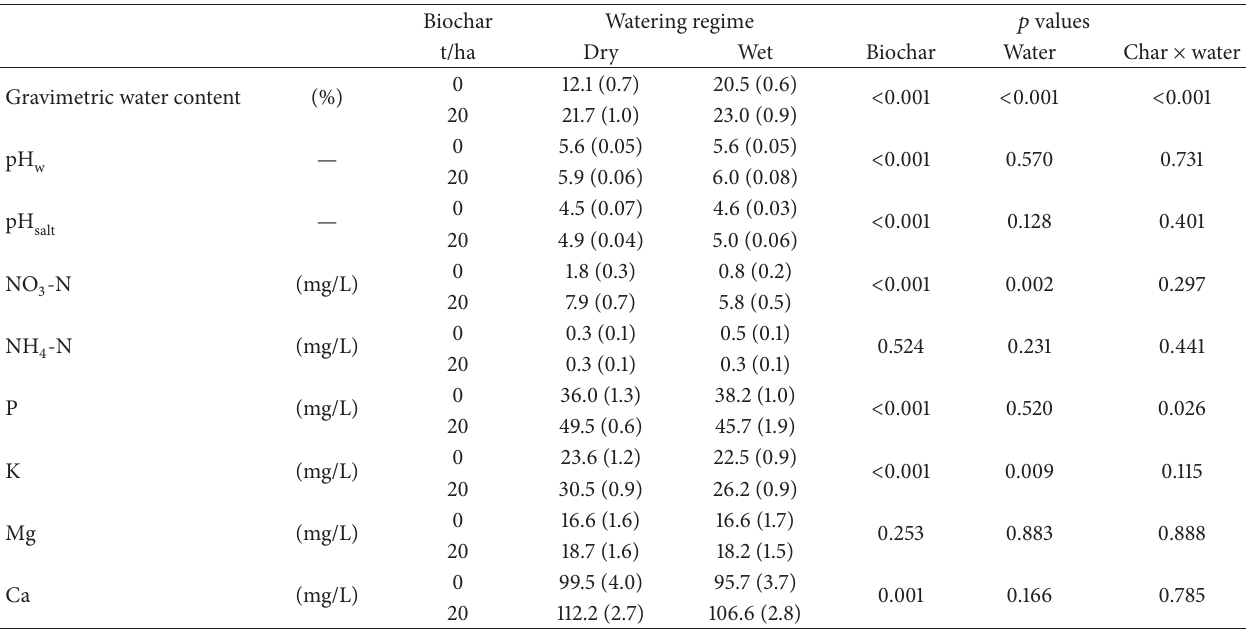
Table 2: Soil properties after a six-month greenhouse trial with lodgepole pine-derived biochar and soil from areas affected by the Church’s Park fire, Colorado. Data are means and standard error in parentheses ( 𝑛 = 6 per